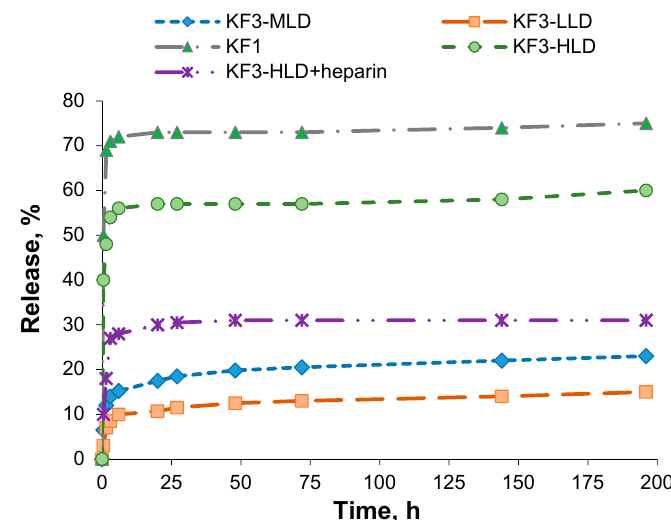
Figure 9. Kinetics of C-peptide release from P(Lys- co - D Phe) nanospheres (37 °C, 0.01 M PBS, pH 7.4).